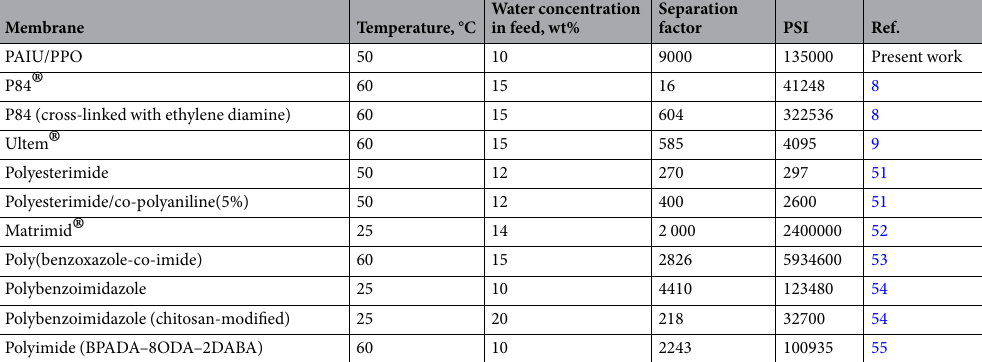
Table 3. Comparison of transport properties of membranes in pervaporation of isopropanol ‒ water